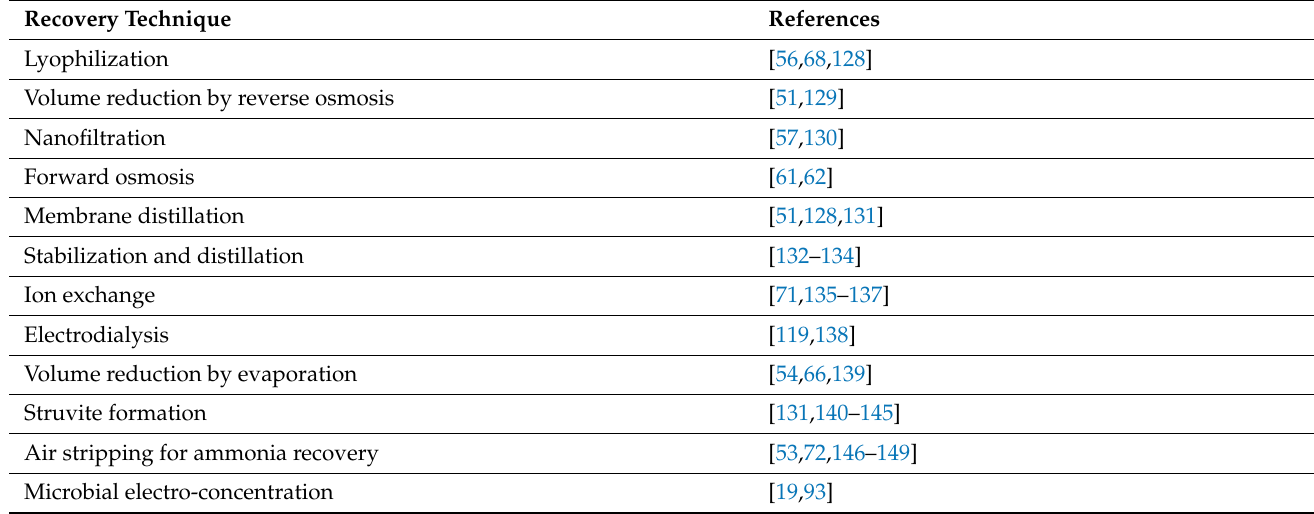
Table A2. Recovery techniques of nutrients from